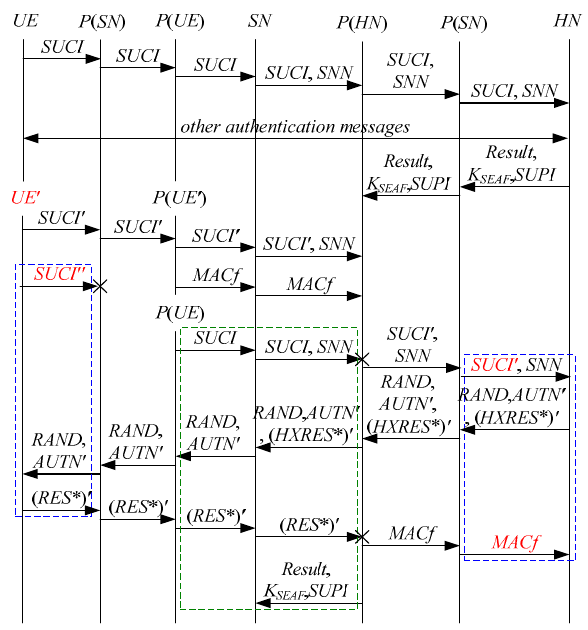
Figure 16. The fifteenth attack scenario of the 5G AKA protocol.